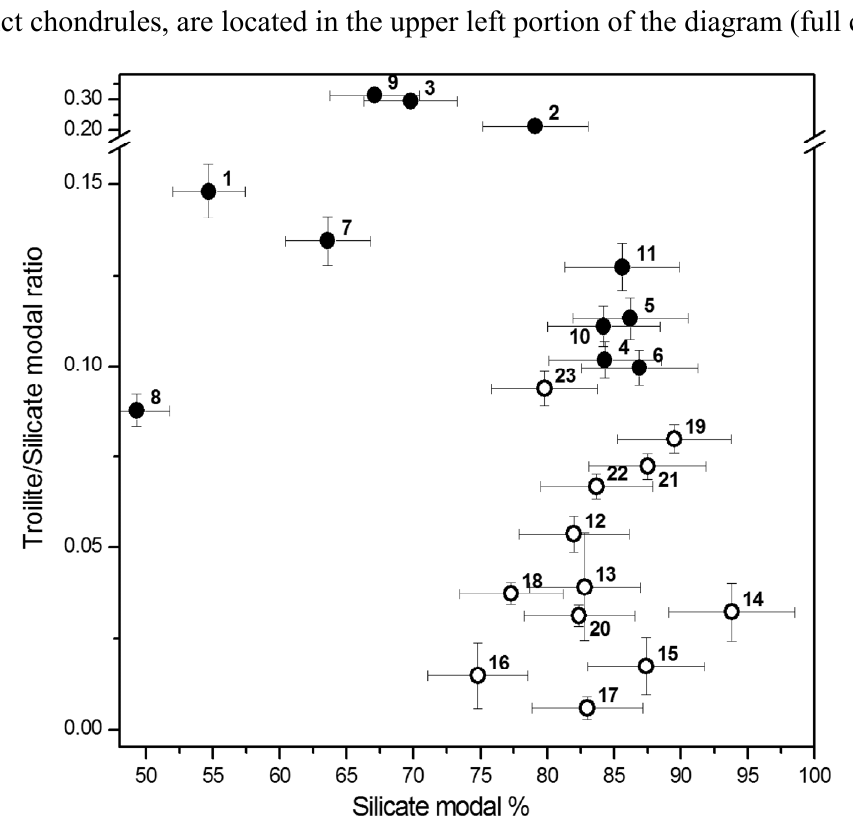
Figure 3. Diagram displaying the troilite/silicate ratio as a function of the total modal